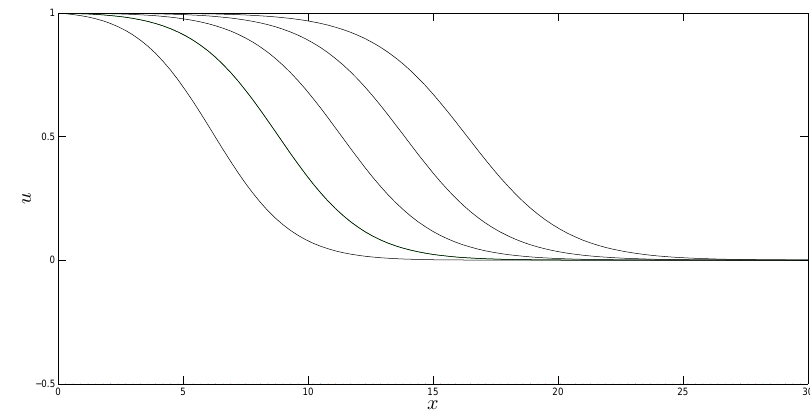
Figure 1: QP is numerically solved for u b = 1 and u + = 0 at times t = 5, 10, 15, 20 and t = 25 .